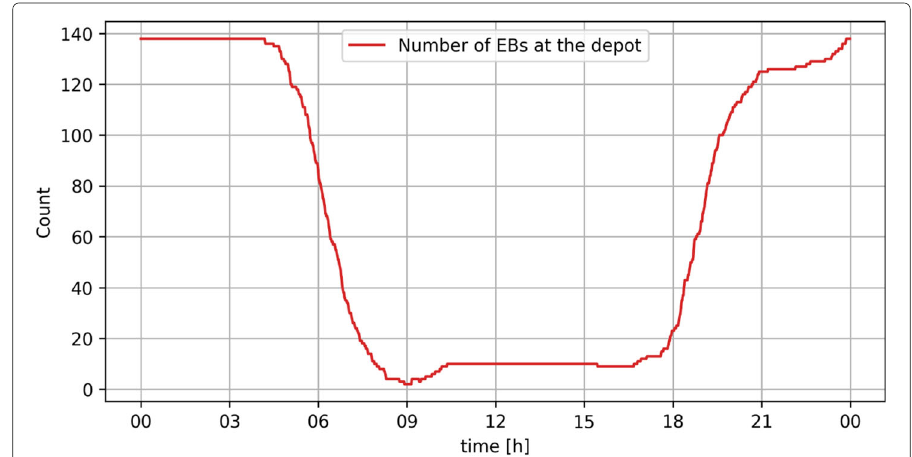
Fig. 2 Number of Buses Parked at the Depot during the Day